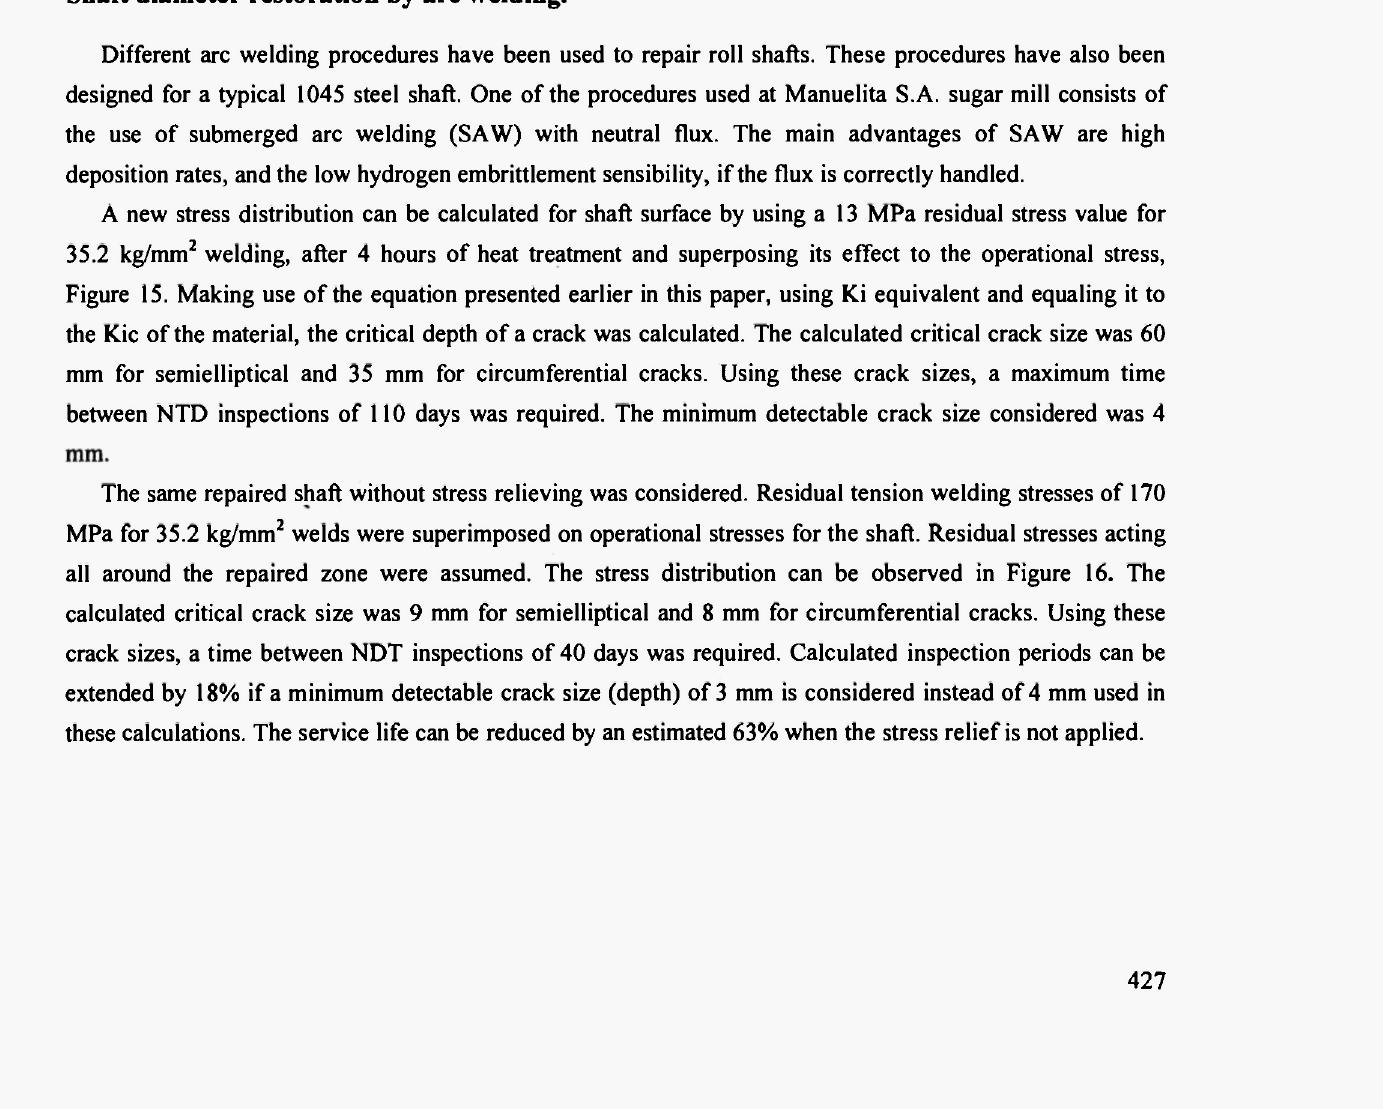
Fig 14: Minimum time between NDT inspections to define the shaft diameters. Shaft diameter restoration by arc welding.